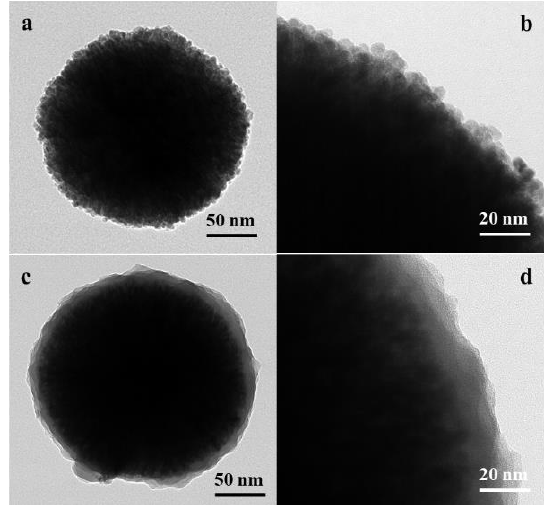
Figure 2. TEM photos of ZnFe 2 O 4 ( a , b ) and ZnFe 2 O 4 /PMA ( c , d ) core-shell microspheres. The chemical components of the ZnFe 2 O 4 /PMA microsphere were identified by FT-IR spectroscopy. The characteristic absorption bands in Figure 3 show the peaks of (a) ZnFe 2 O 4 , (b) PMA-coated ZnFe 2 O 4 , and (c) PMA, respectively. In Figure 3a, 3432 and 1630 cm − 1 peaks for O–H bonding, 507 cm − 1 for the natural vibration frequency of Zn 2+ , and 415 cm − 1 for the octahedral group of Fe 3+ O 2 − [38]. The characteristic peaks of the PMA near 2820 and 1302 cm − 1 were allocated to the NCH 3 bending vibration and C–N stretching vibration, respectively [39]. The solid red line indicates that the PMA-coated ZnFe 2 O 4 exhibited absorption peaks for both ZnFe 2 O 4 and PMA. In the case of ZnFe 2 O 4 /PMA, the ZnFe 2 O 4 -affected peak intensity was weakened by the PMA coating.